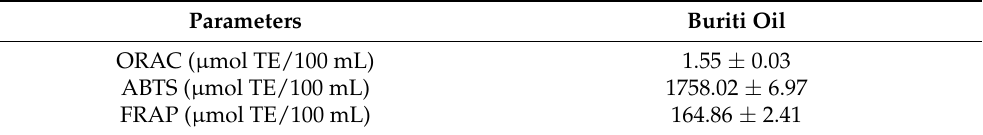
Table 4. Antioxidant activity of buriti